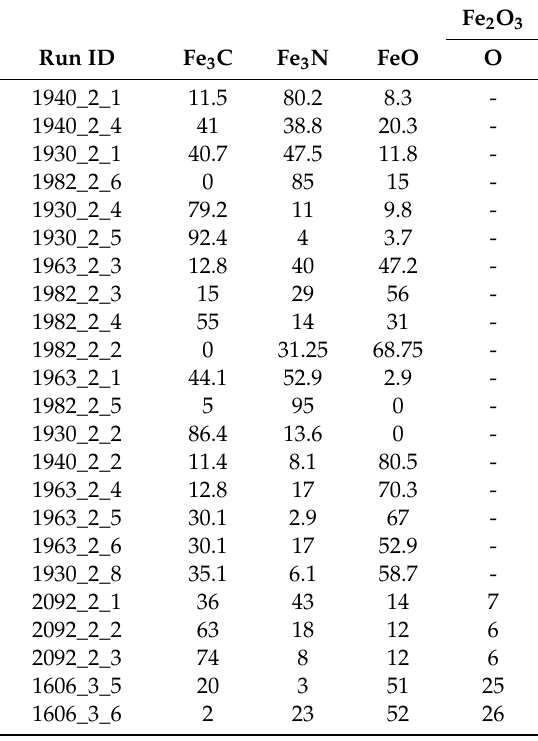
Table 1. Starting compositions (mol